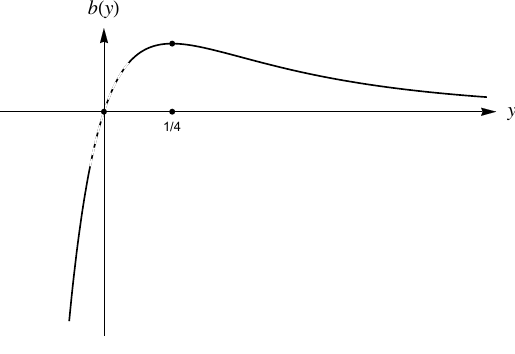
Figure 6. Plot of b ( y ) in a neighborhood of the